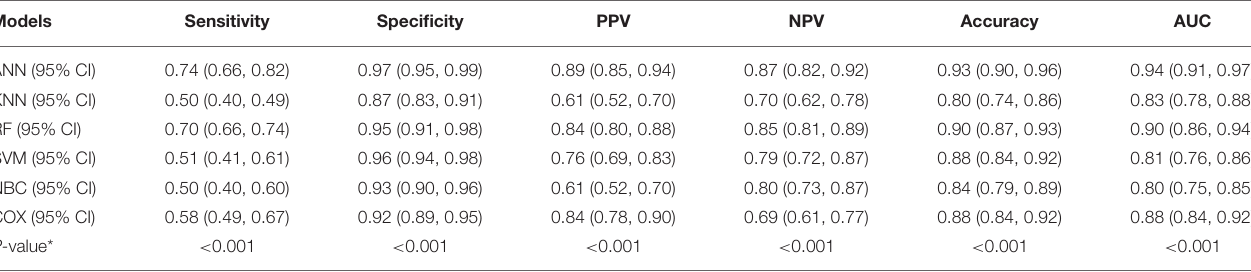
TABLE 6 | Comparative performance indices of forecasting models when using 167 new validating datasets to predict 30-day readmission in patients with stroke.